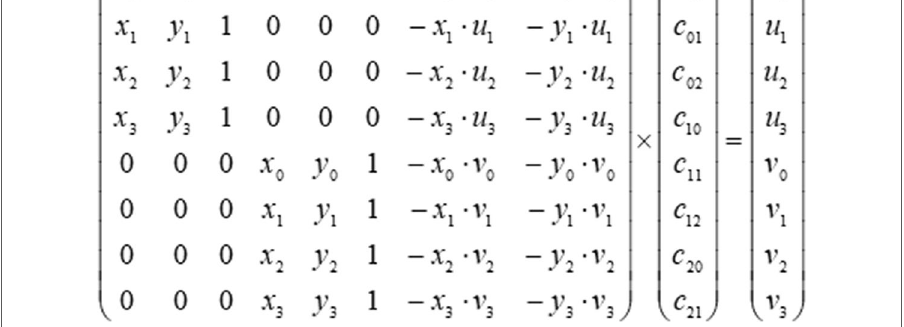
Fig. 14 The matrix form of the solved equations